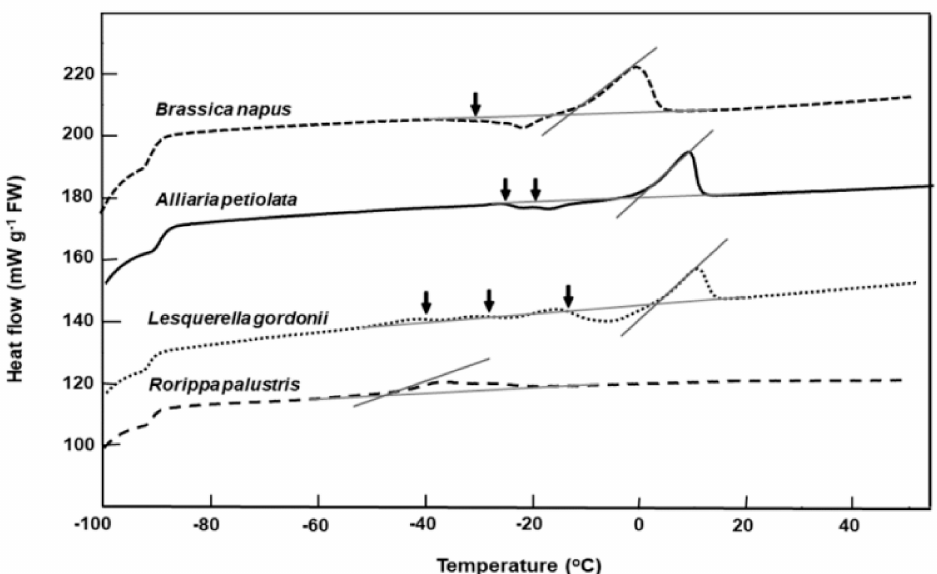
Figure 2. Comparative warming thermograms for seeds of four Brassicaceae species from the RBG Kew collection. Seeds were cooled / warmed at ± 10 ◦ C min − 1 . Onset temperatures for the main lipid melts coincide with the intersect between the tangent to the steepest part of the melting peak and the scanning baseline. Lipid crystallization during warming is indicated ( ↓ ). Multiple